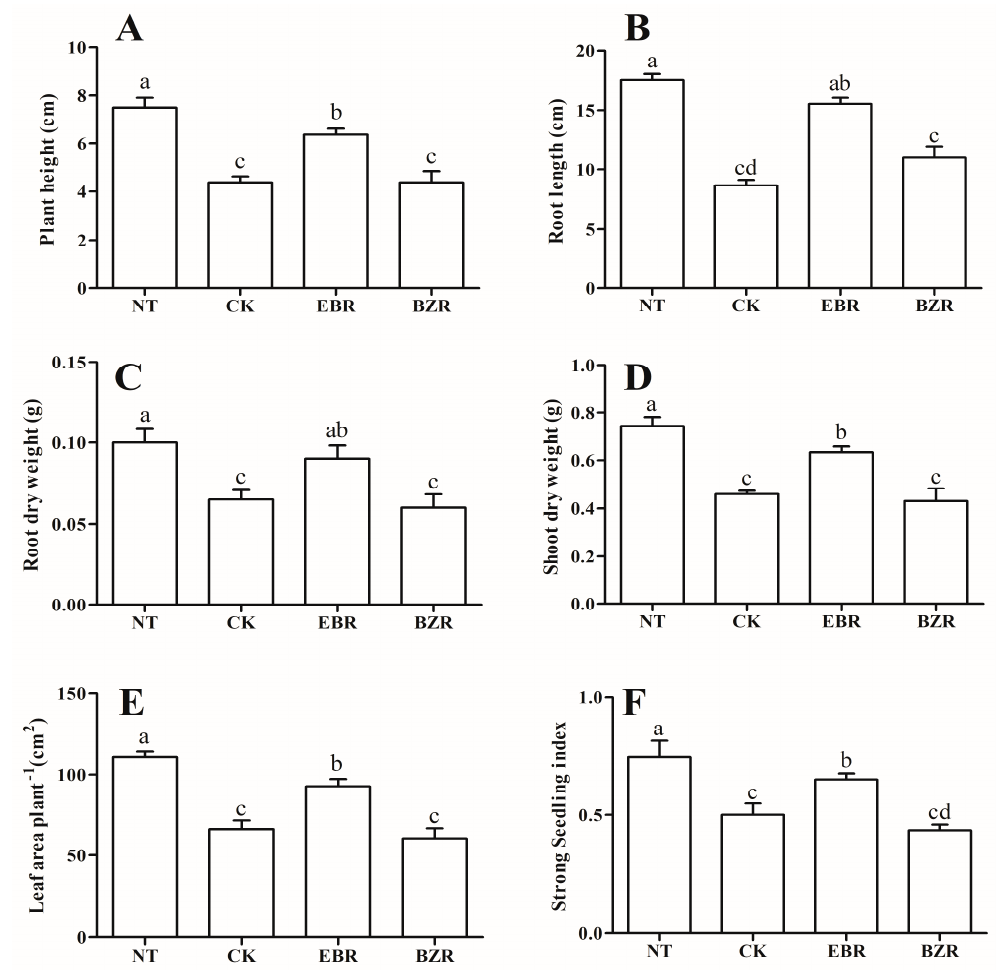
Figure 1. Effect of EBR application and low-temperature stress on cucumber seedling growth (( A ) plant height, ( B ) root length, ( C ) root dry weight, ( D ) shoot dry weight, ( E ) leaf area) and ( F ) the strong seedling index. Different letters indicate significant differences at p < 0.05.